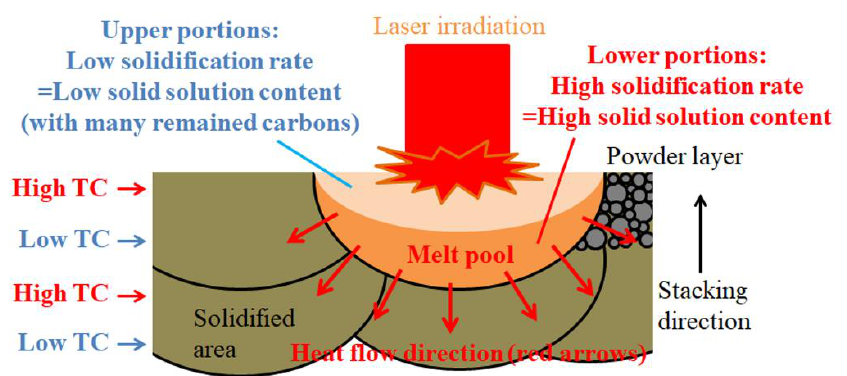
Figure 18. OM images of the ( a ) XY, ( b ) XZ, and ( c ) YZ cross sections of the Cu plated C/Al SLM composite fabricated with XD scanning pattern. Broken lines indicate solidification boundaries of beads.